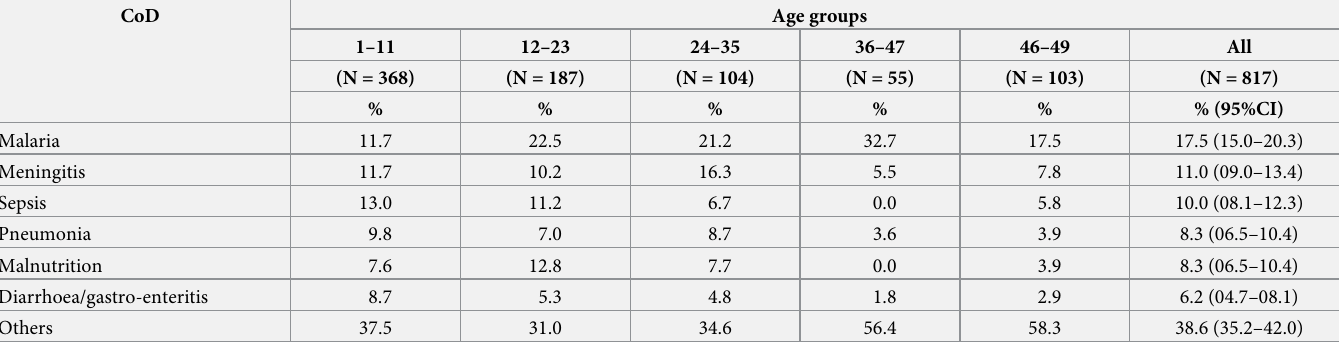
Table 3 presents the distribution of clinically diagnosed and laboratory confirmed pneumococ- cal disease associated CoD. Overall, more than 55% of cases (n = 158) diagnosed with clinically Table 1. Distribution of the main CoD in children 1–59 months old in Yaounde´, 2006–2012 (N =